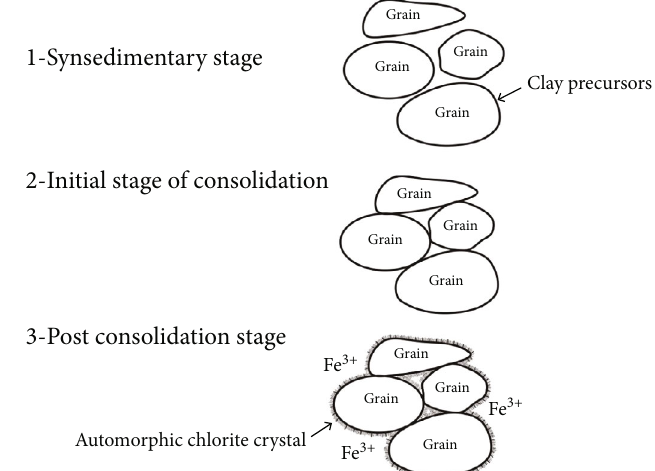
Figure 10: Diagram of formation process of the chlorite clay fi